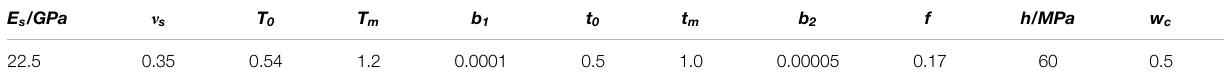
TABLE 1 | Parameters of the fi tted model.